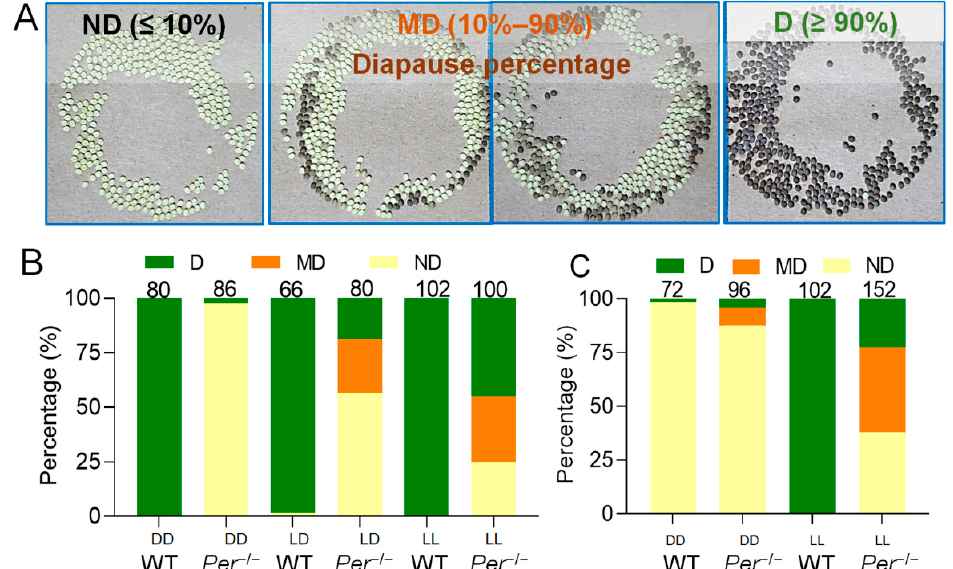
Figure 2. Per -knockout affects the determinative effect of incubation temperature and light on the diapause of offspring eggs. ( A ) Three diapause phenotypes of eggs (batches) produced by female moths. ND, non-diapause egg batch, the proportion of diapause eggs ≤ 10%; MD, the mixed batch of diapause eggs and non-diapause eggs, the proportion of diapause eggs was 10–90%; D, the diapause egg batch, the proportion of diapause eggs was ≥ 90%. In the photos, the yellow eggs are non-diapause eggs, and the dark brown eggs are diapause eggs. ( B ) At 25 °C incubation temperature, the effect of the incubation light regimes (DD, LD and LL) on the diapause of offspring eggs ( n = 66–102 batches). ( C ) At 20 °C incubation temperature, the effect of the incubation light regimes (DD and LL) on the diapause of offspring eggs ( n = 72–152 batches). The numbers of the egg batches are marked above the corresponding column.